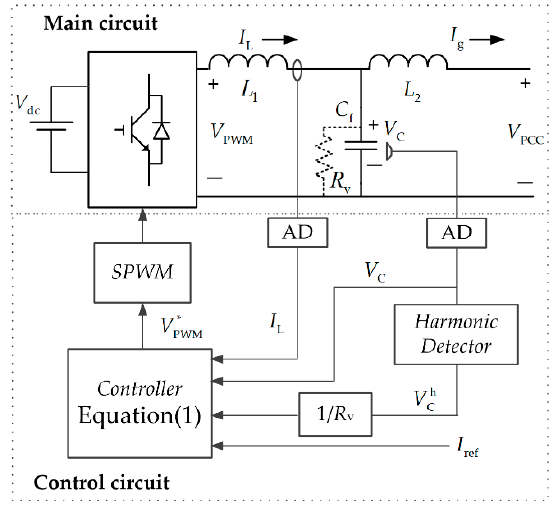
Figure 2. Conventional proportion-controlled DG system with virtual damping.